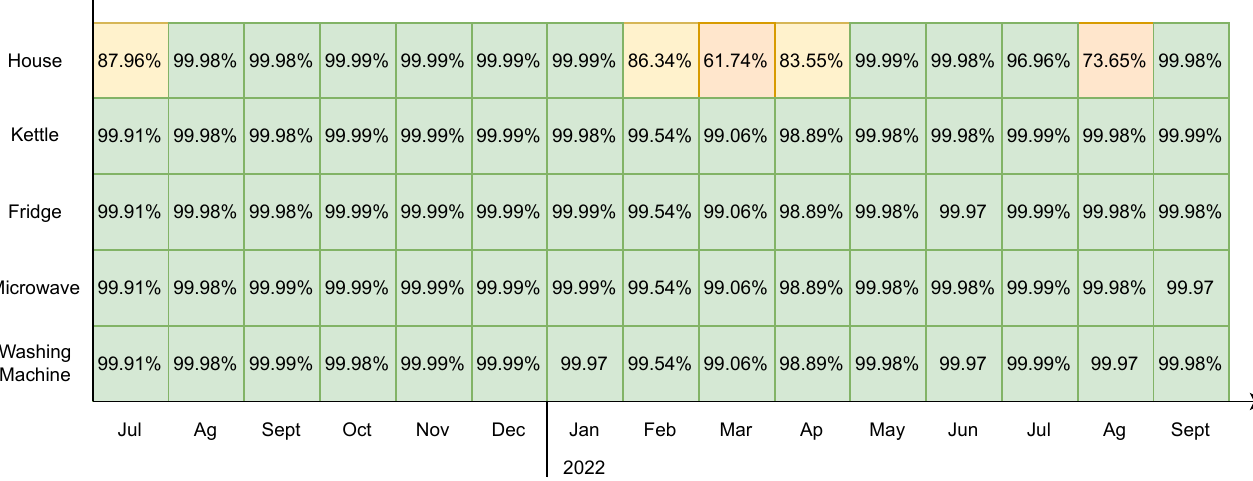
Figure 10. Analysis of system availability for the collected